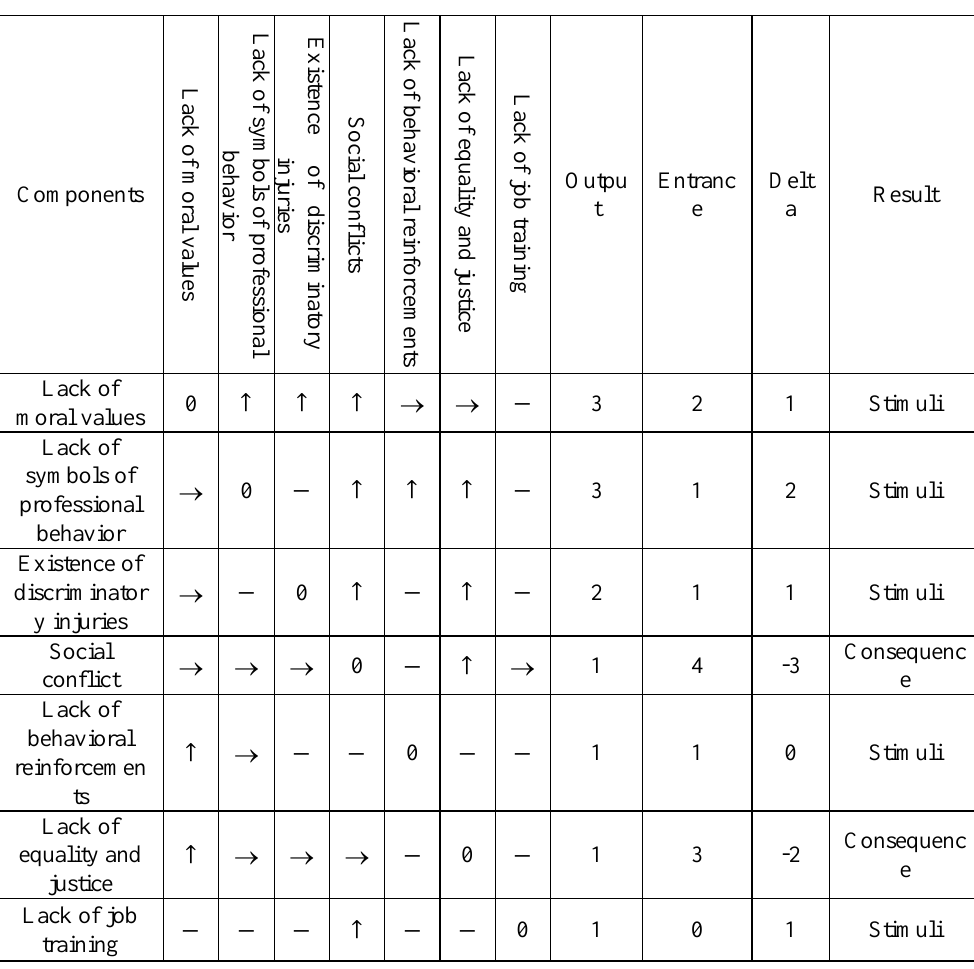
Table 8. Affinity Relationship Links (ART) Causes of behavioral alienation of trusted